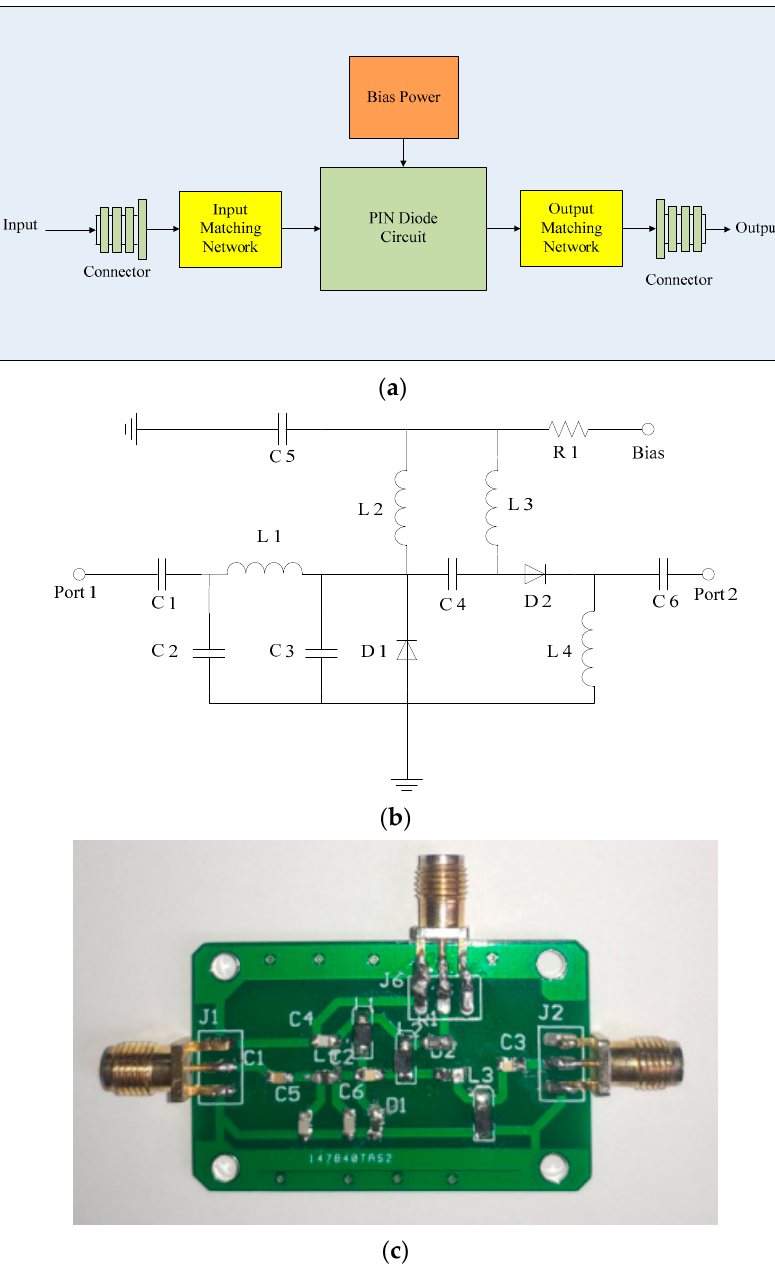
Figure 9. Series-shunt PIN switch: ( a ) block diagram of improved PIN switch ( b ) analog of the circuit